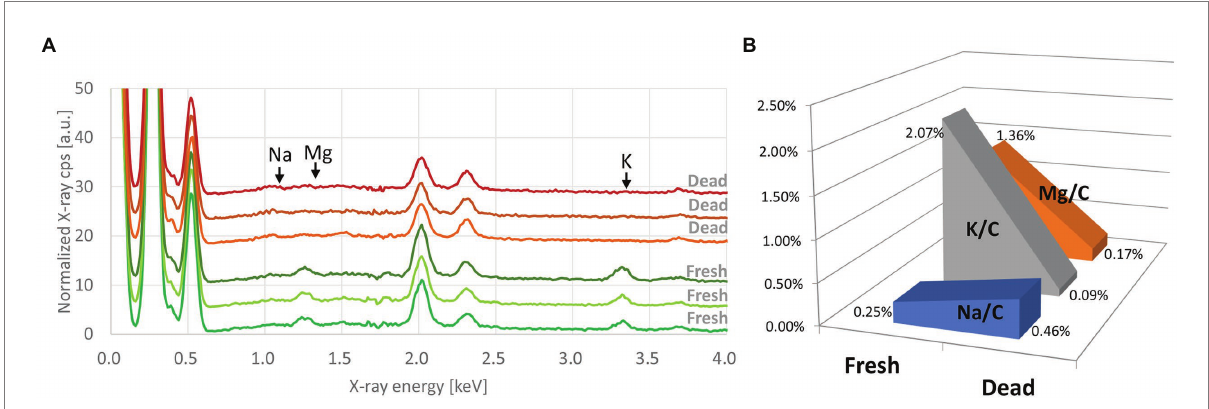
FIGURE 1 (A) Processed EDX spectra of fresh and heat-killed Escherichia coli (Q5586). Each curve represents the average of three spectra taken from the same bacterial deposition. Spectra are offset by 3. (B) Evolution of the K/C, Mg/C, and Na/C ratios between the fresh and the heat-killed E. coli